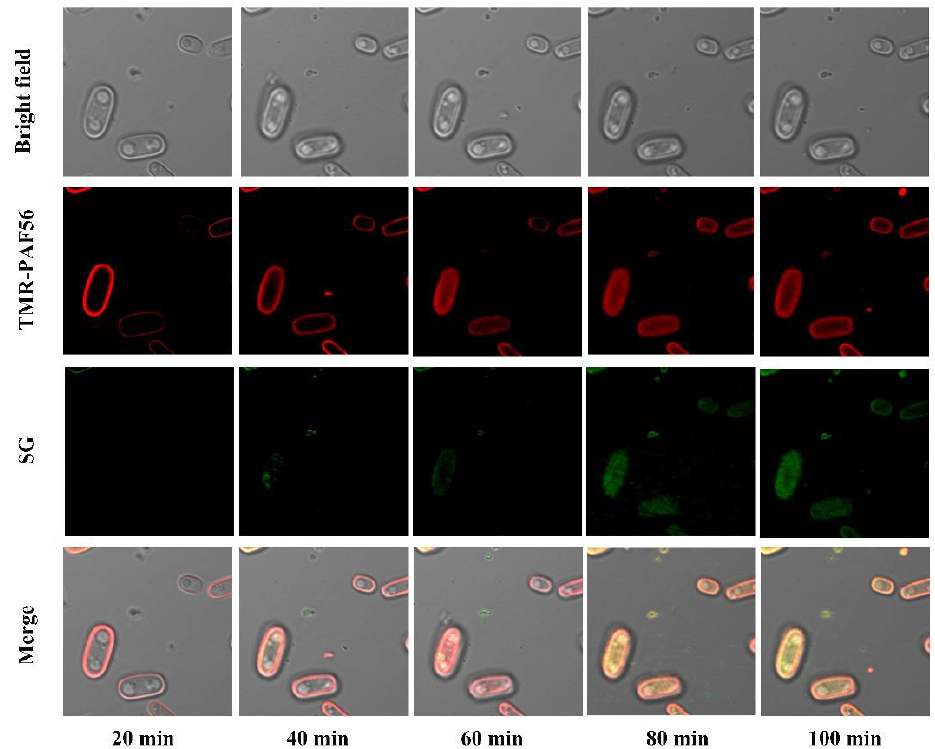
Figure 6. Time-lapse confocal fluorescence microscopy analyses of the interaction of TMR-PAF56. Spores were incubated in light-safe microcentrifuge tubes. Subsequently, TMR-PAF56 and fluorescent dye SG were added. The suspensions were photographed by an Olympus FV1000 laser confocal microscope with FITC filter and Rhodamine Red-x sets at different time points. Simultaneous brightfield images were also photographed.